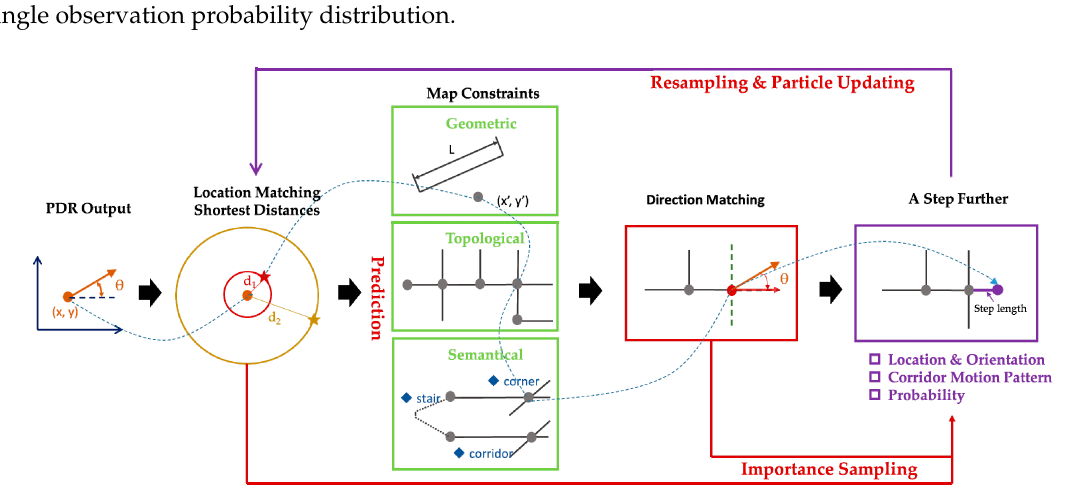
Figure 7. The graph matching-based particle filter during one iteration.